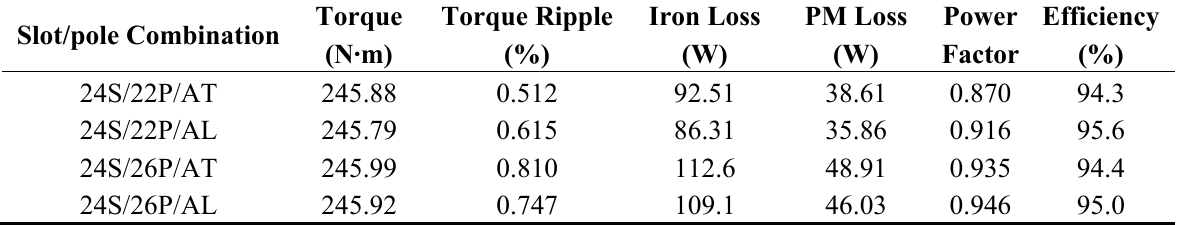
Table 3. Results of finite element